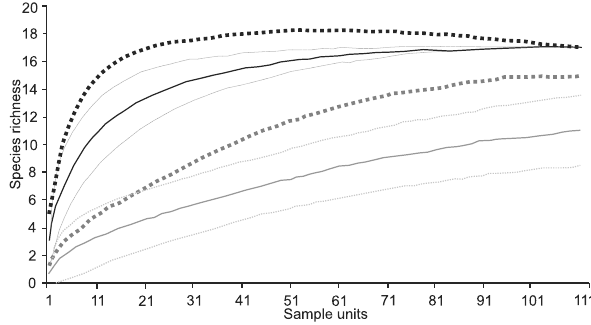
Figure 62. Species accumulation curves (solid lines) and richness index (first order Jackknife) for amphibians (black) and reptiles (grey) sampled by pitfall traps during field surveys in the Parque Natural Municipal Nascentes de Paranapiacaba, Santo André, São Paulo. Dashed lines represent respective standard